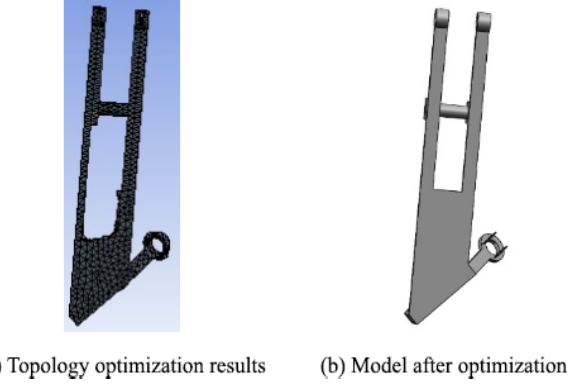
Figure 15. The cloud diagrams of the optimized stress and defor- mation of the clamping arm.